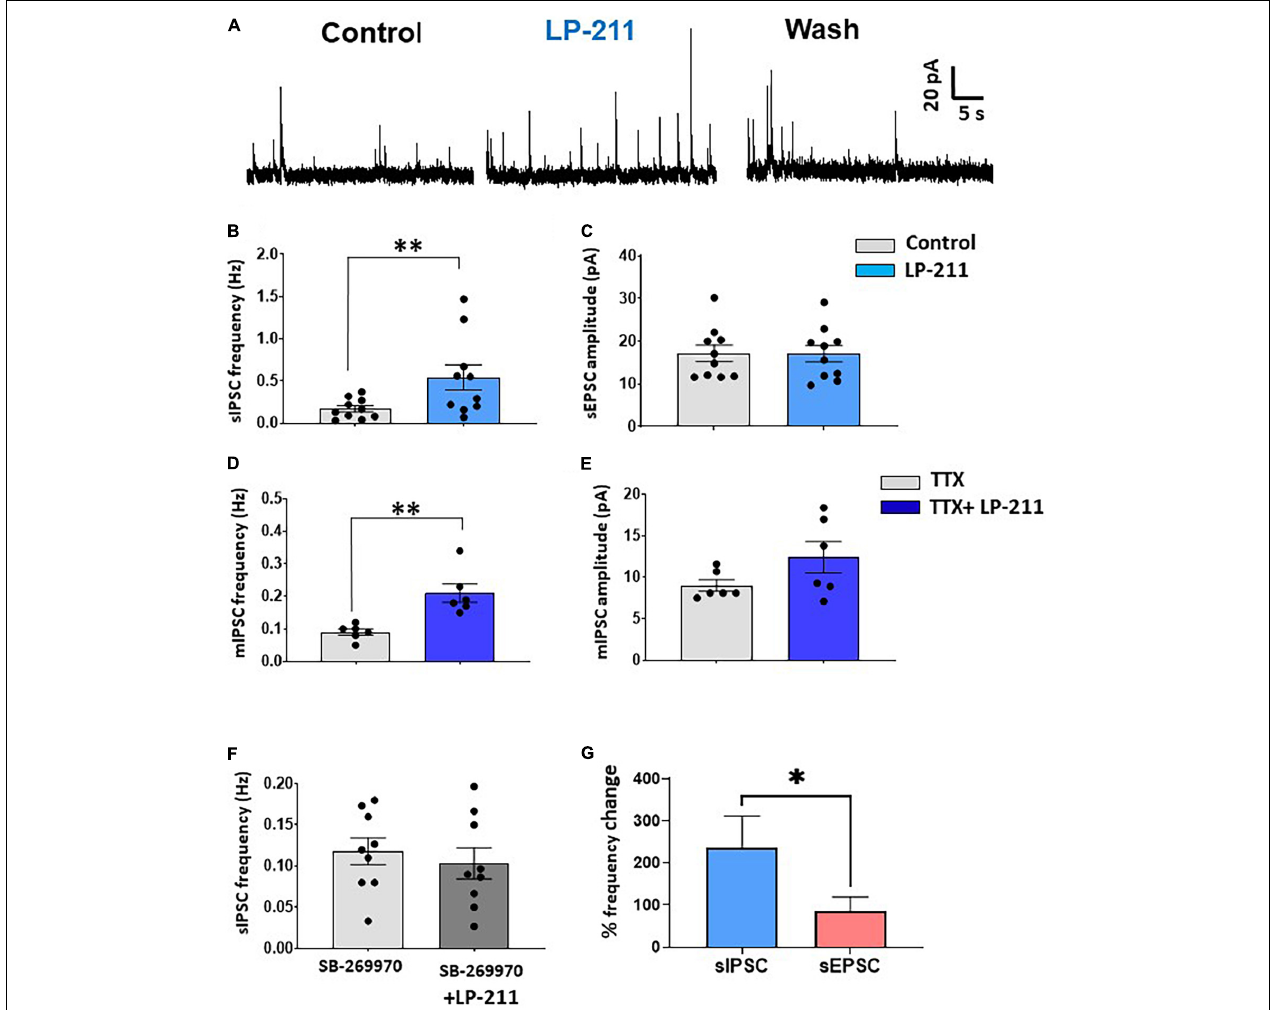
FIGURE 2 | Activation of 5-HT 7 Rs by LP-211 potentiates spontaneous GABA and glycine release. (A) Representative traces of spontaneous inhibitory postsynaptic currents (IPSCs), recorded in voltage-clamp at 0 mV, in the presence of the AMPA and NMDA receptor antagonists NBQX (10 µ M) and D-AP5 (50 µ M). An increase in sIPSC frequency was evident in the presence of LP-211 (1 µ M). (B,C) Summary graphs obtained from the lamina II neurons responsive to LP-211. The agonist caused a significant increase of sIPSC frequency in 10 out of 14 tested cells [ (B) paired t -test, p < 0.01, n = 10], without affecting the mean sIPSC amplitude (paired t -test, p = 0.96, n = 10). (D,E) In the presence of 1 µ M TTX, LP-211 still produced a significant increase in mIPSC frequency in 6 out of 11 cells tested [ (D) paired t-test, p < 0.01, n = 6], while mean mIPSC was not altered [ (E) paired t -test, p = 0.12, n = 6]. (F) Co-application of LP-211 with SB-269970 (10 µ M) inhibited the increase of sEPSC frequency, confirming the involvement of 5-HT 7 Rs (zero responsive cells out of 9 tested, paired t -test, p = 0.21, n = 9). (G) LP-211 exerted a stronger effect on sIPSC frequency as compared to sEPSC (Mann–Whitney test, p < 0.05, n = 10 and 9, for sIPSCs and sEPSCs, respectively). Asterisks reported in the graphs represent statistical significance: ∗ p < 0.05; ∗∗ p < 0.01; ∗∗∗ p <